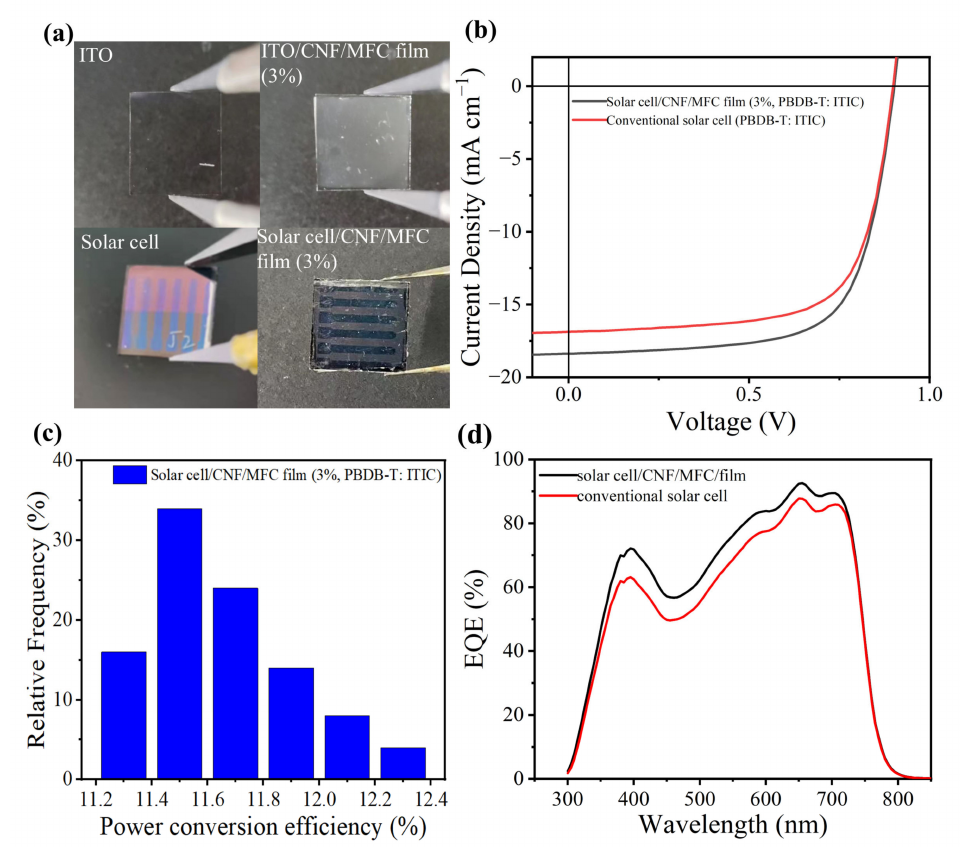
Figure 7. Application of light management thin films in organic solar cells. ( a ) Digital images